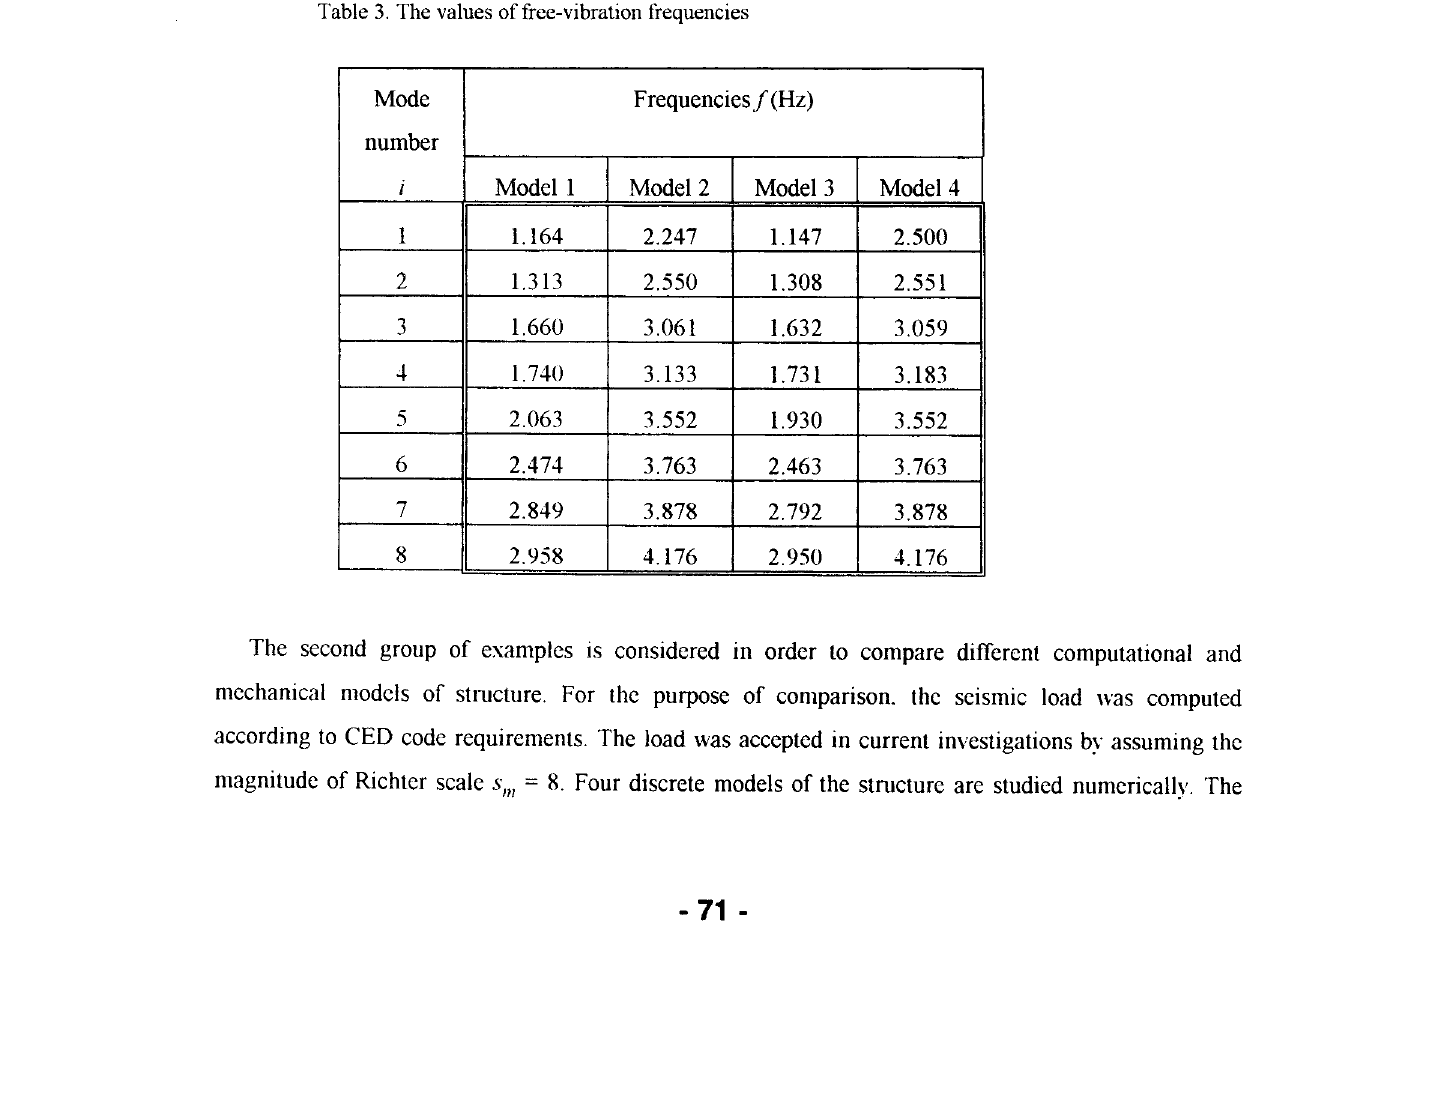
Table 3. The values of free-vibration